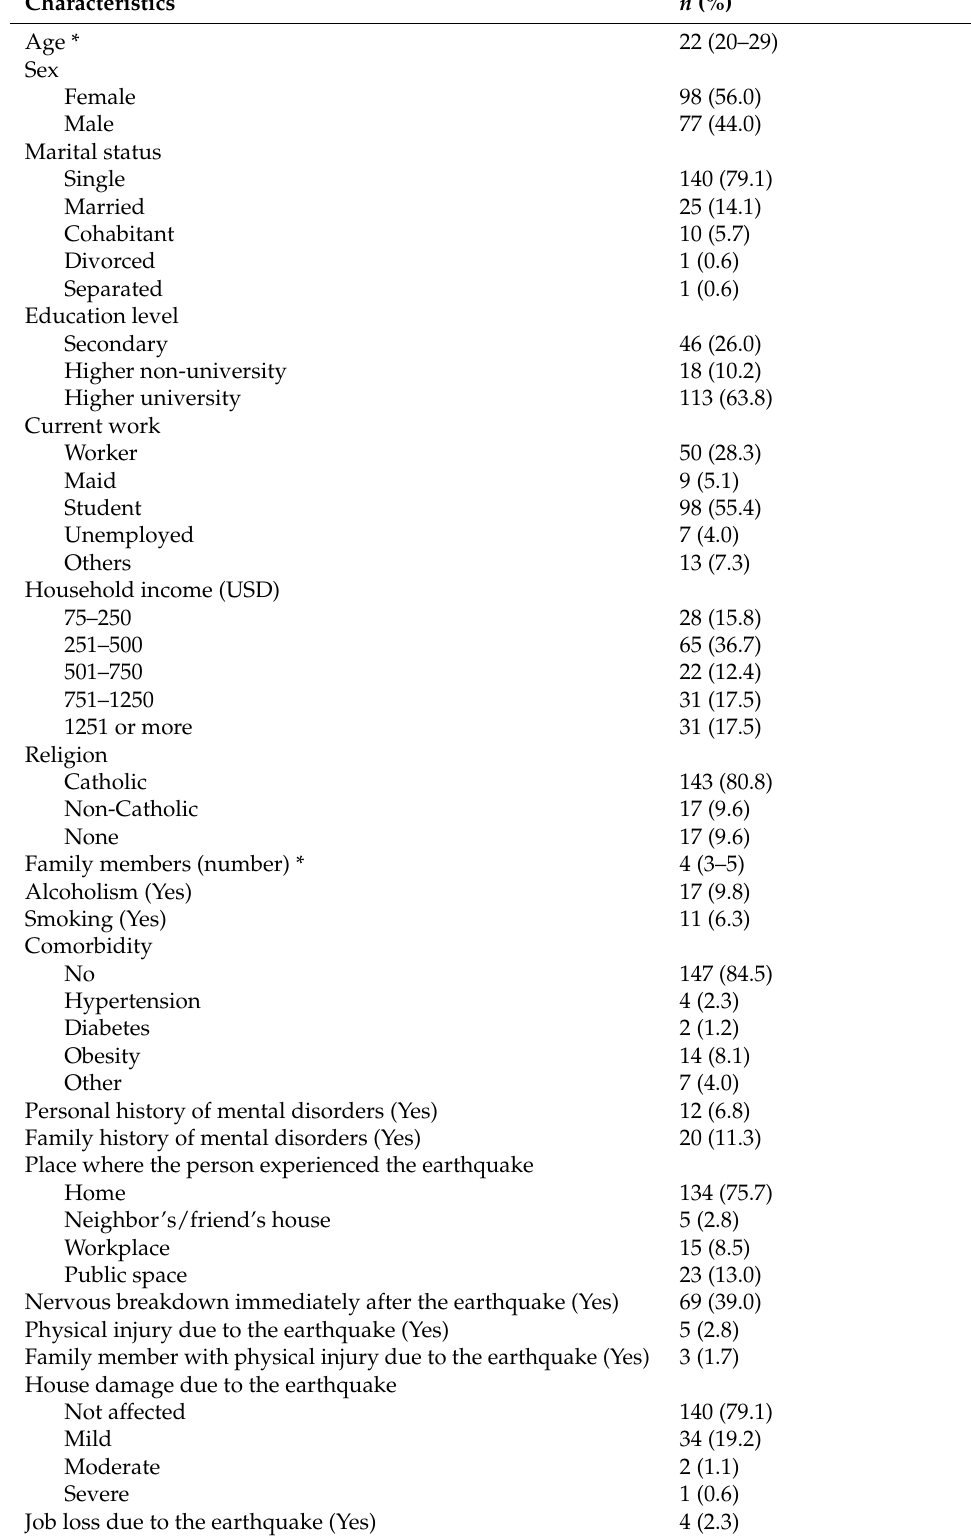
Table 1. Participant characteristics ( n =